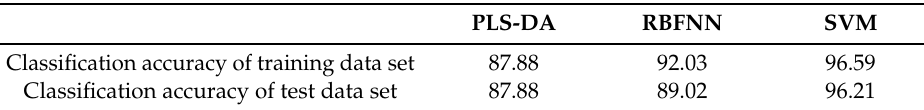
Table 4. Classification accuracy of different classifiers